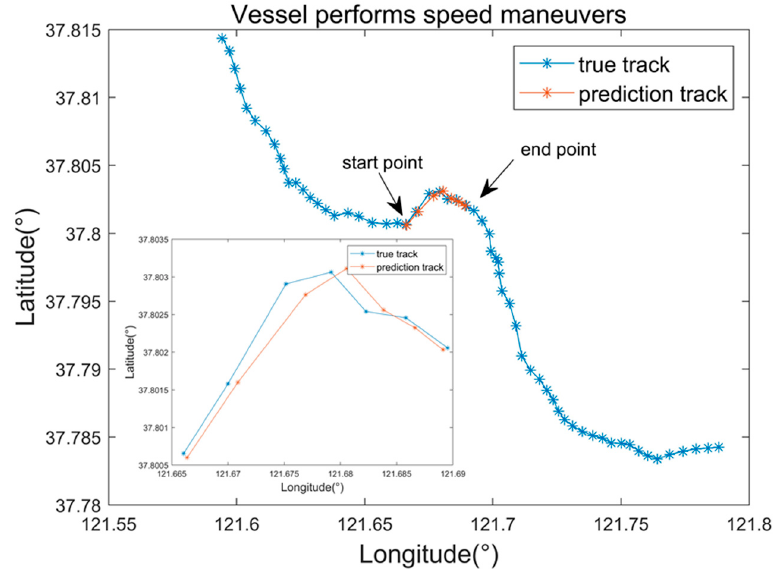
Figure 17. The part of the trajectory broken during the course maneuvers. The blue and brown lines show the real and predicted tracks, respectively. The box in the lower left compares the real and predicted tracks at the point where the break occurred.